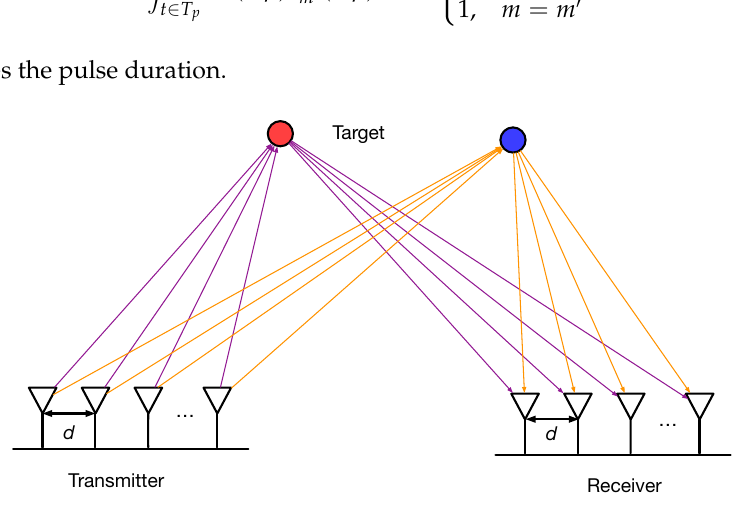
Figure 1. The system model of the bistatic MIMO